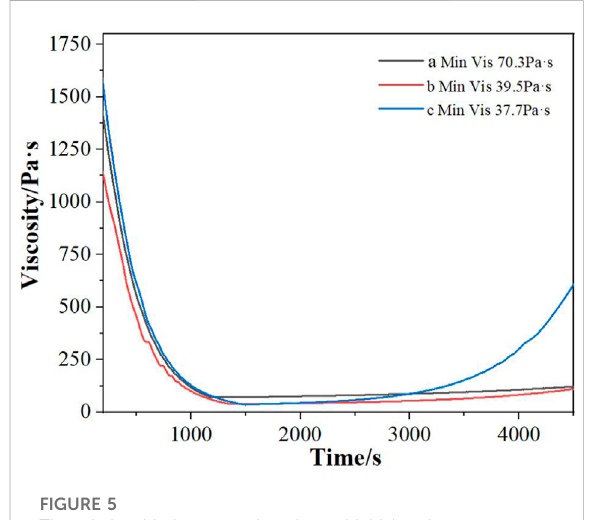
FIGURE 5 The relationship between viscosity and initial curing temperature of VBO resin system (a) at 70 ° C; (b) at 80 ° C; (c) at 90 ° C.